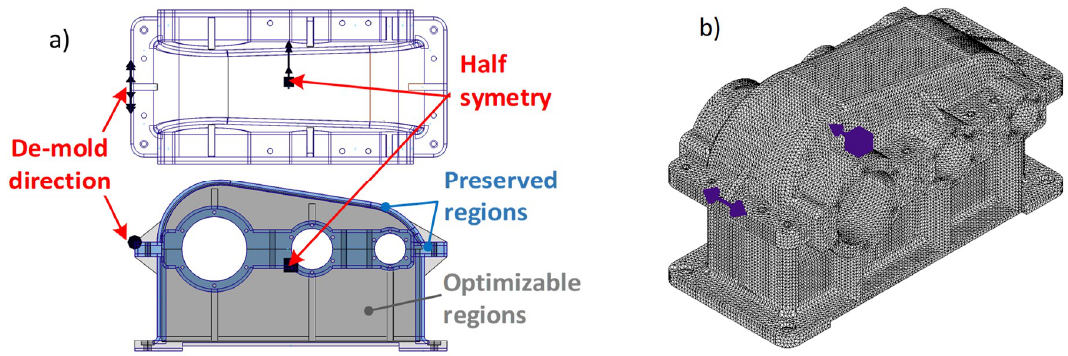
Figure 6. ( a ) Defined manufacturing controls and preserved regions in the 3D model; ( b ) meshed 3D model of the reducer housing.